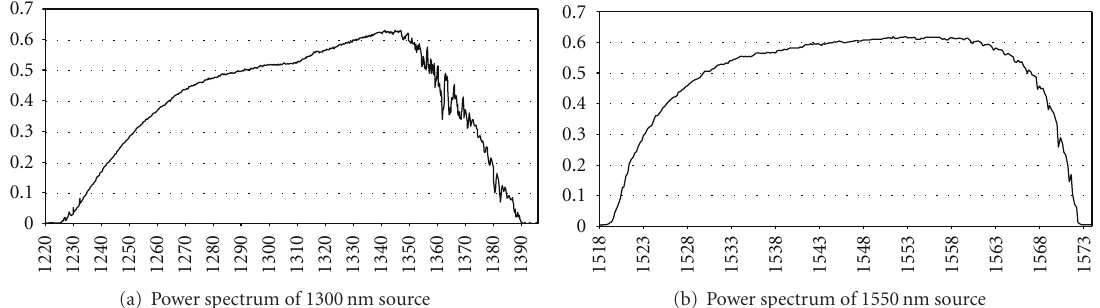
Figure 3: Power spectrums of (a) 1300 nm swept source; (b) 1550 nm swept source.